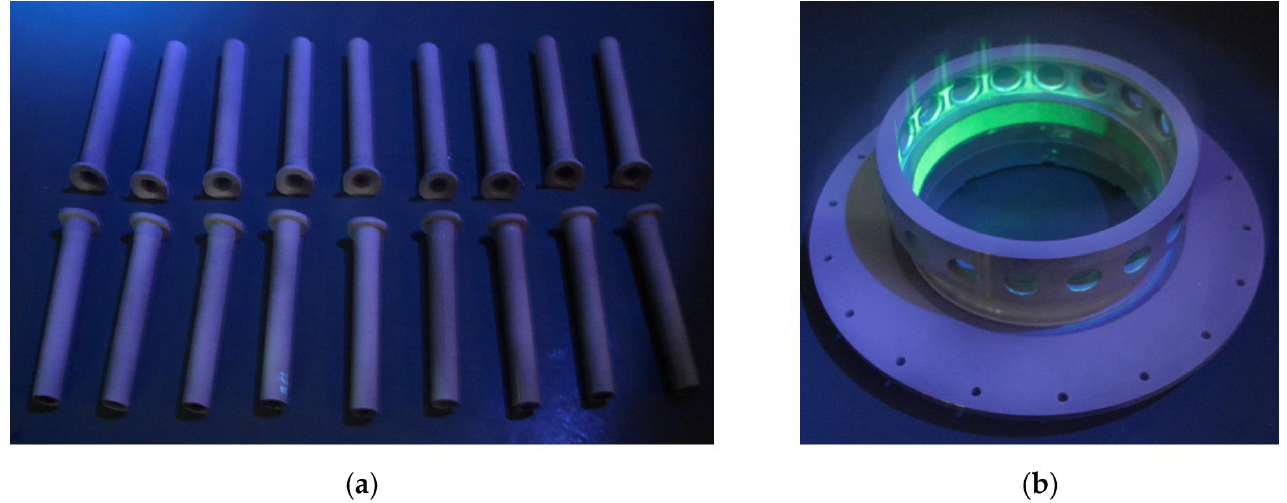
Figure 12. Fluorescence nondestructive examination: ( a ) The air tubes; ( b ) The support ring.